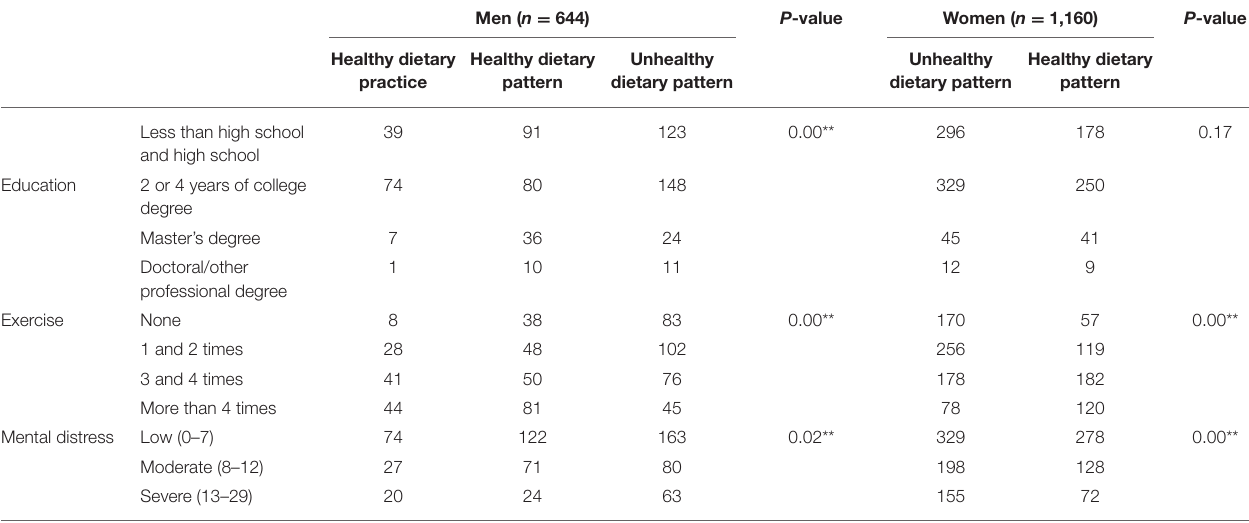
TABLE 1 | Participants characteristics of men and women according to dietary patterns identified by the cluster